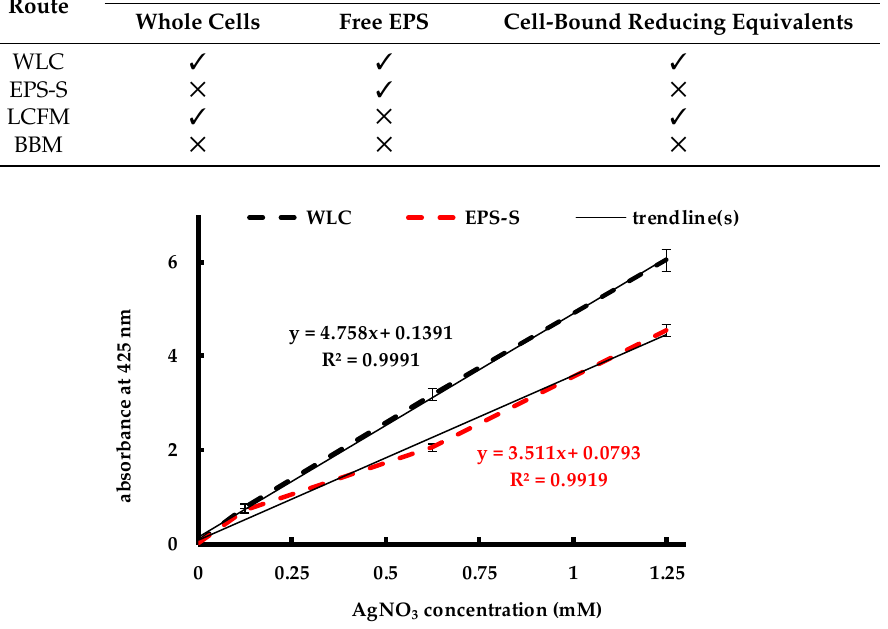
Figure 4. Dependence of maximum stabilized AgNPs as a function of AgNO 3 input.